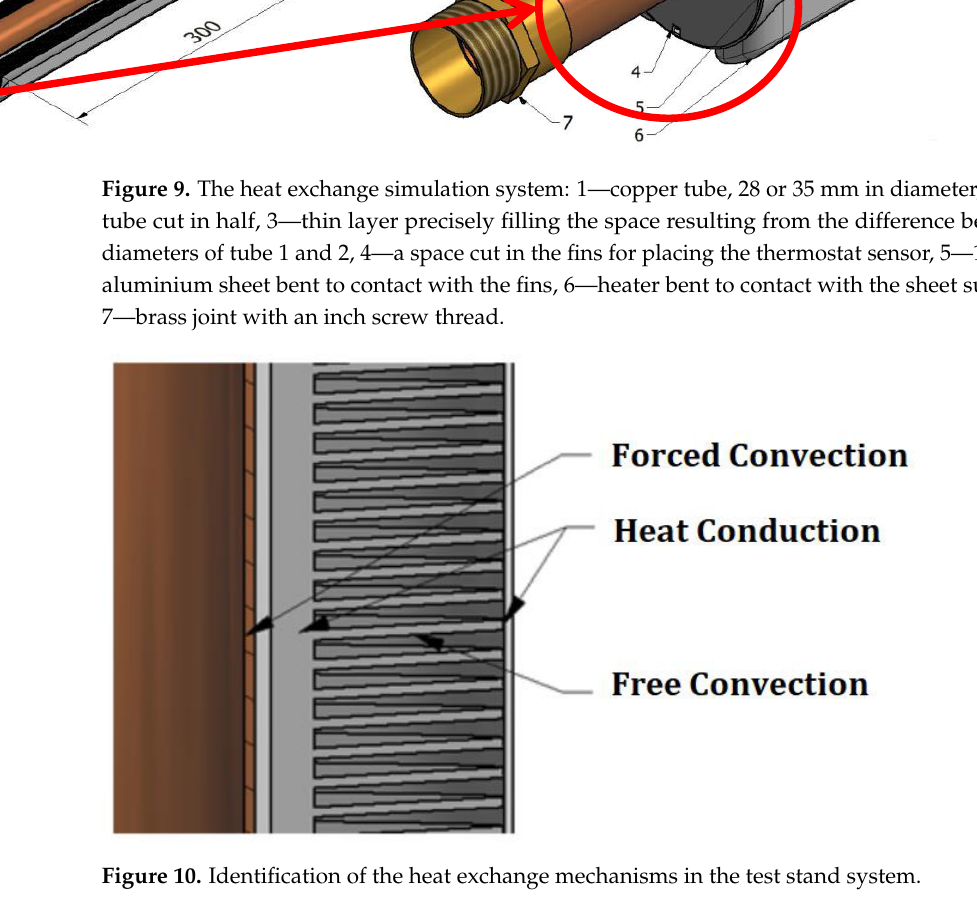
Figure 10. Identification of the heat exchange mechanisms in the test stand system.